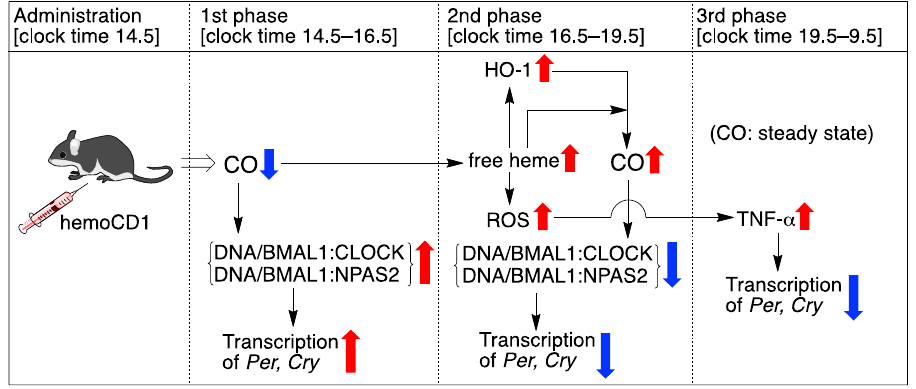
Figure 8. A mechanism for the circadian clock disruption caused by the hemoCD1-mediated endogenous CO depletion in mice. The components of Fig. 8 were drawn using